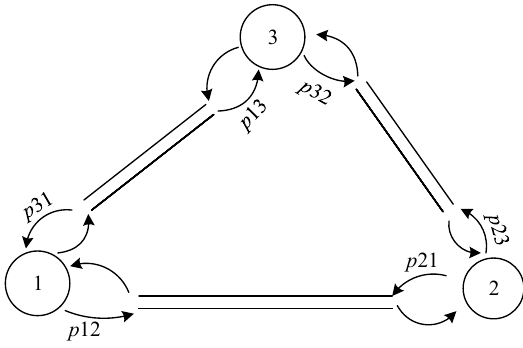
Figure 2. Traffic network diagram of three stations.